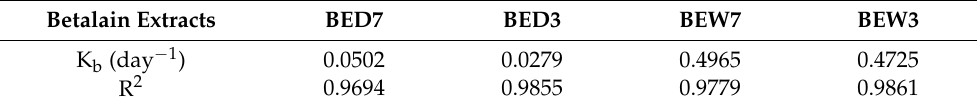
Table 3. Values of K b constant and correlation coefficient R 2 to the first-order kinetic model for betalain degradation from DES proportion 2:1 and water extracts. Betalain